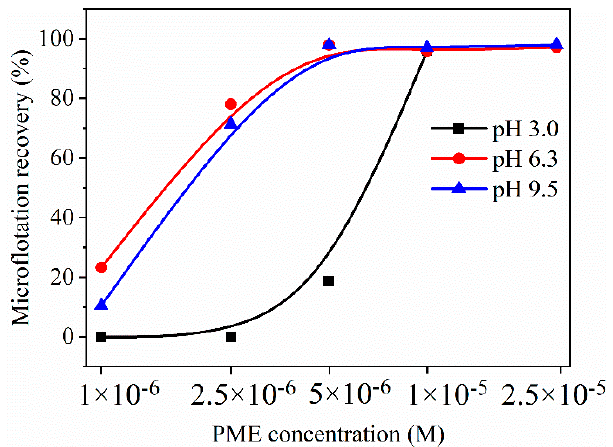
Figure 4. Barite flotation response as a function of lauryl phosphate concentration at pH 3.0, pH 6.3, and pH 9.5.